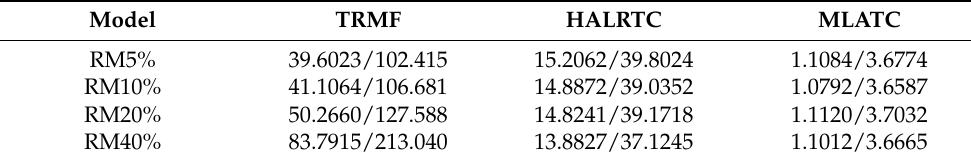
Table 3. Evaluation metrics for data prediction in the RM case (MAPE/RMSE).